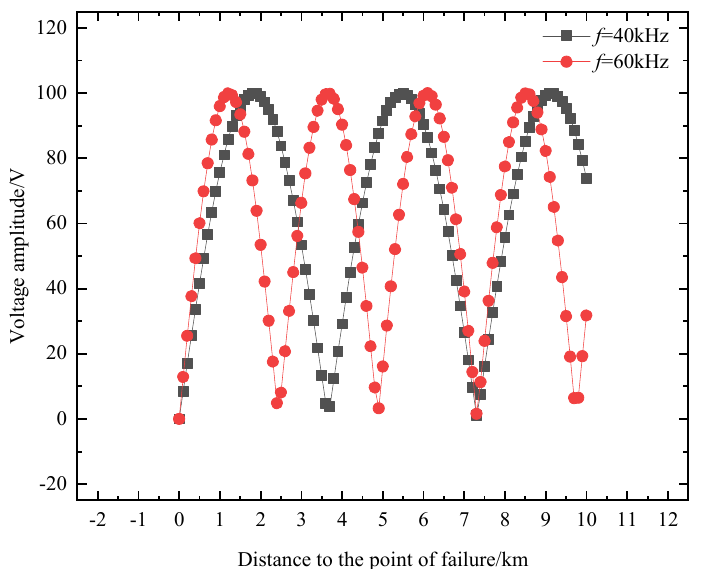
Figure 3. Simulation of the full-period variation of the lossless standing wave, corresponding to different frequency input signals, when a ground fault occurs at 10 km.